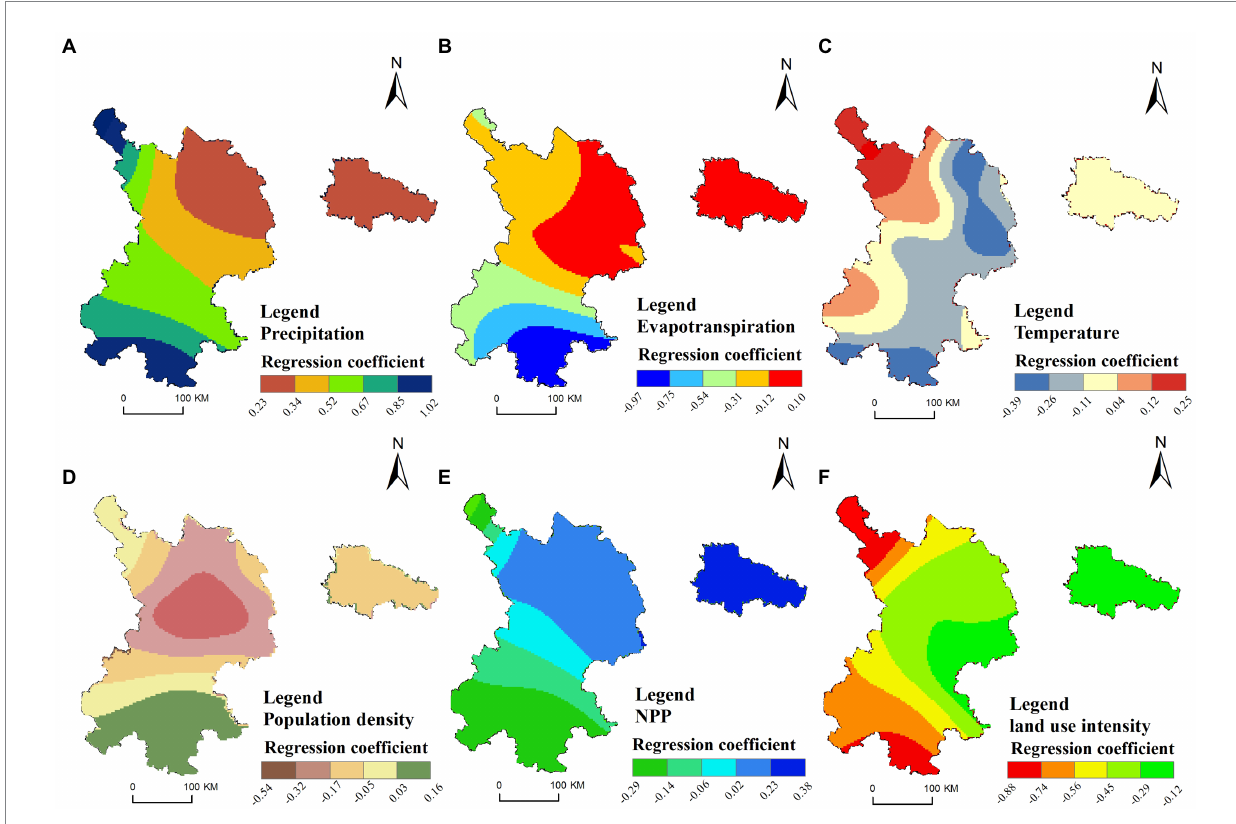
FIGURE 6 The spatial characteristics of the main influencing factors on WYs. The factors are listed in order of relative importance (A–F)